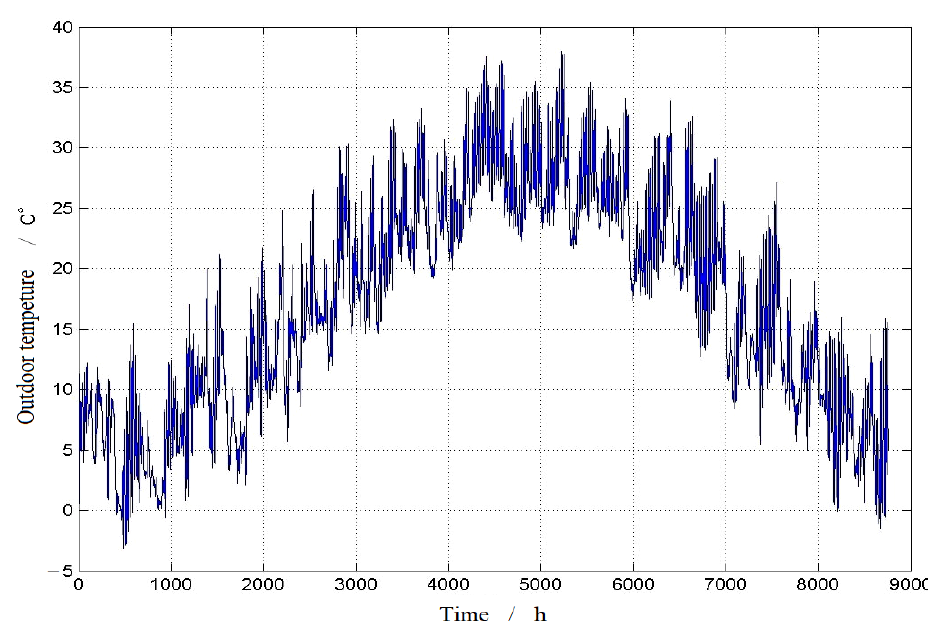
Figure 5. Annual hourly outdoor ambient temperature.